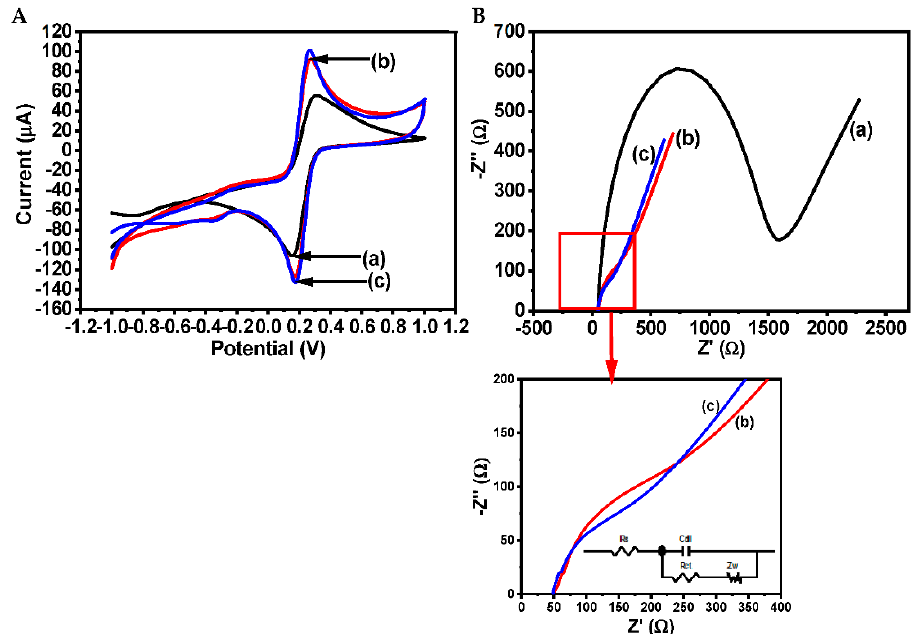
Figure 3. Electrochemical characterization of electrodes; ( A ) cyclic voltammograms of [Fe(CN) 6 ] 3 − /4 − redox couple in 5 mmol · L − 1 K 3 [Fe(CN) 6 ] in 0.1 mol · L − 1 KCl solution at bare PGE (a), redox couple in 5 mmol·L −1 K 3 [Fe(CN) 6 ] in 0.1 mol·L −1 KCl solution at bare PGE (a), ERGO-PGE (b), and ERGO-SbNPs-PGE (c) at a scan rate of 50 mV·s −1 , and the corresponding Nyquist plot ( B ) from the peak currents.